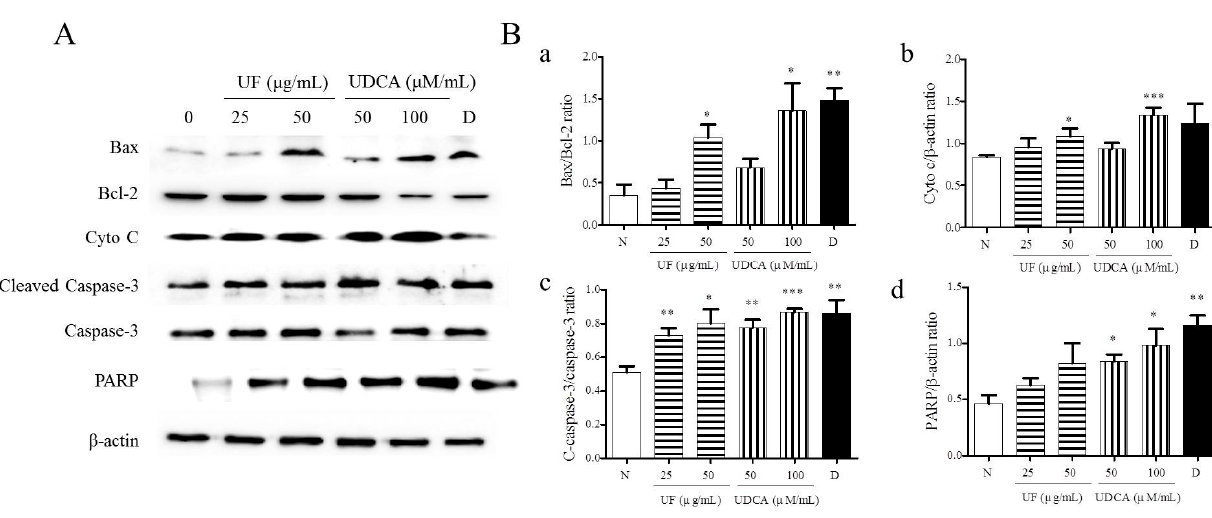
Figure 3. Effects of UF extract and UDCA on the expression of apoptotic proteins in human FRO anaplastic thyroid cancer cells. The cells were treated with UF extract or UDCA at indicated concentrations for 48 h. The expression of Bax, Bcl-2, cytochrome c (Cyto C), caspase-3, cleaved caspase-3 (C-caspase-3), and PARP proteins was determined by western blotting. ( A ) β -Actin was used as an internal control. The expression of Cyto C ( b ) and PARP ( d ) was calculated relative to β -actin expression. The expression of Bax was calculated relative to Bal-2 expression. ( a ) The expression of caspase-3 was calculated relative to cleaved caspase-3 expression. ( c ) The data are representative of three independent experiments. * p < 0.05, ** p < 0.01, and *** p < 0.001 vs. normal cells. ( B ) N, untreated cells; UF25, 25 μ g/mL UF extract treatment; UF50, 50 μ g/mL UF extract treatment; UDCA50, 50 μ M/mL UDCA treatment; UDCA100, 100 μ M/mL UDCA treatment; D, 2 nM/mL docetaxel treatment.